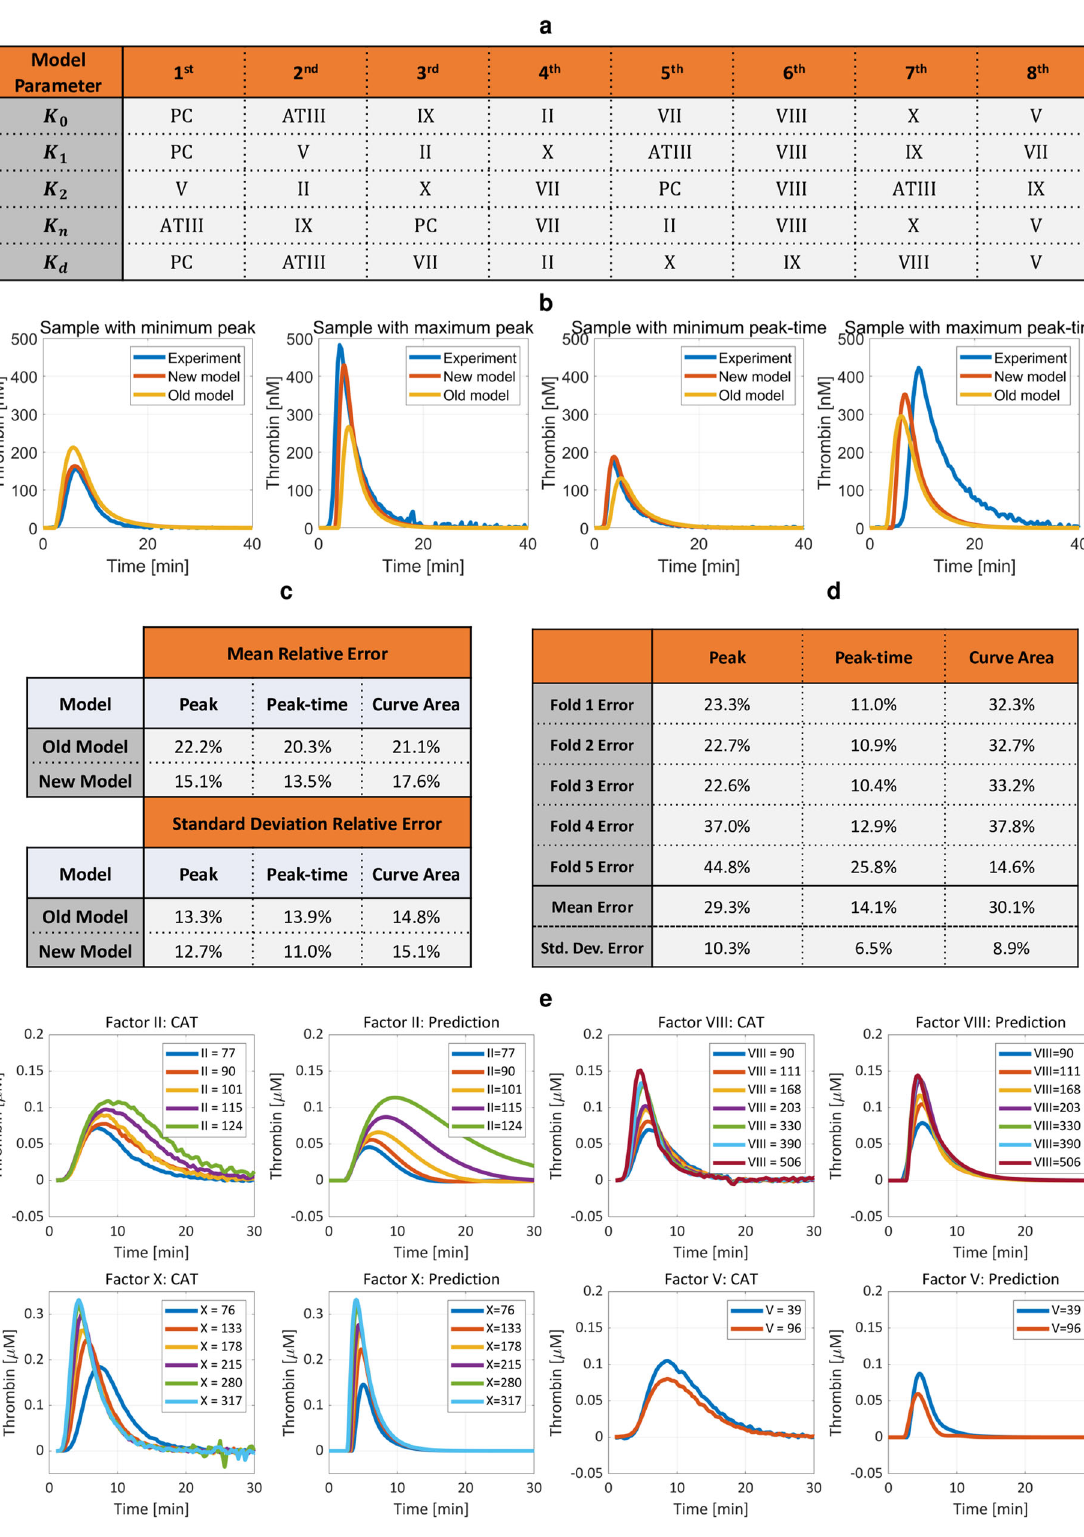
validated it using fi ve normal samples, dataset 9, that were different from dataset 4, which was used for identi fi cation. We contrasted the CAT pro fi le of these fi ve validation samples against the normal region (Supplementary Fig. 9) using mean relative error (MRE), the mean of the error at each time point where the